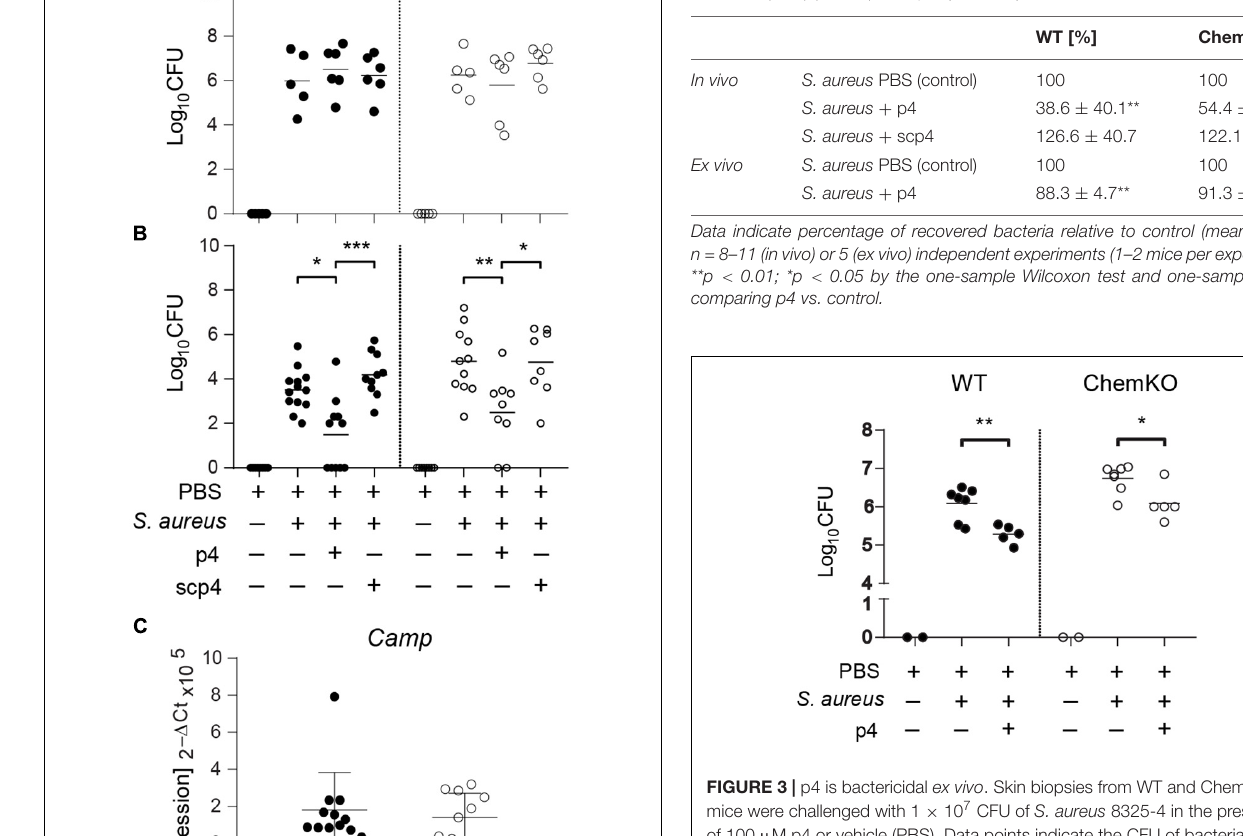
TABLE 2 | WT and ChemKO mice ( in vivo ) or skin biopsies taken from these mice ( ex vivo ) were challenged with 1 × 10 7 CFU of S. aureus 8325-4 in the presence of vehicle (PBS) (control), 100 µ M p4, or scp4 for 24 h.